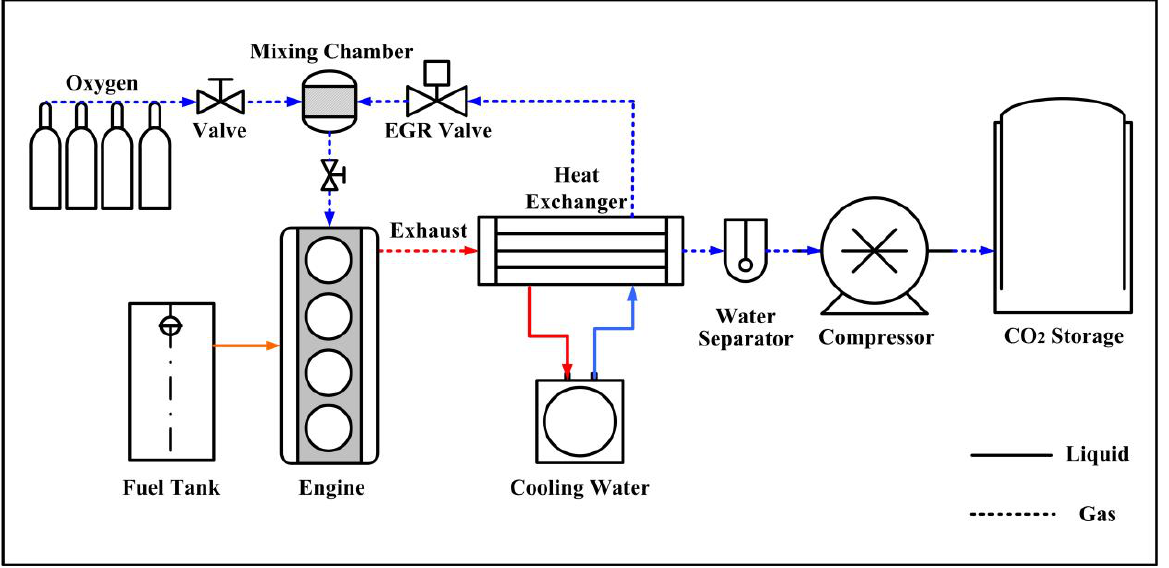
Figure 1. Schematic of OFC with CCS in the application of ICE.